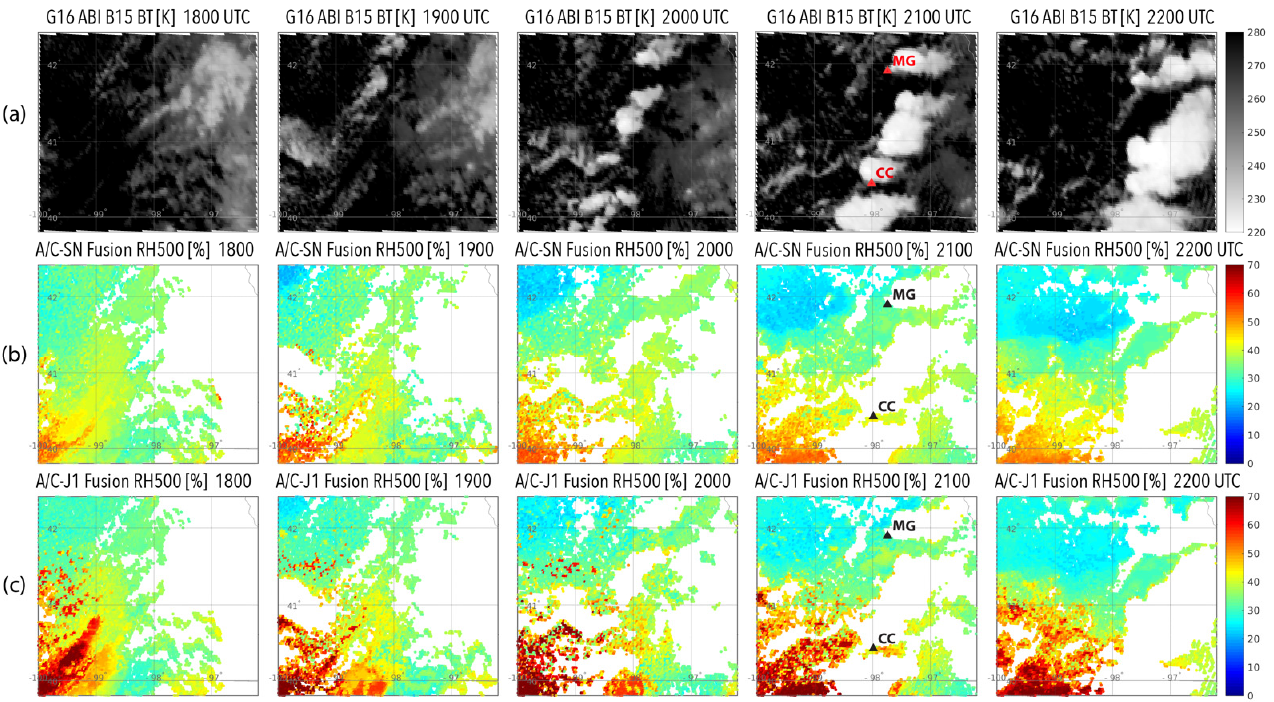
Figure 3. ( a ) ABI Band 15 (12.3 μ m) brightness temperature (BT) measured every hour from 1800 to 2200 UTC; ( b ) 10 min temporal ABI/CrIS-SNPP (A/C-SN) fusion results of RH, starting at the SNPP overpass time at 1900 UTC, are shown every hour from 1800 to 2200 UTC; and ( c ) 10 min temporal ABI/CrIS-JPSS-1 (A/C-J1) fusion results of RH, starting at the JPSS-1 overpass time at 1950 UTC, are shown every hour from 1800 to 2200 UTC.